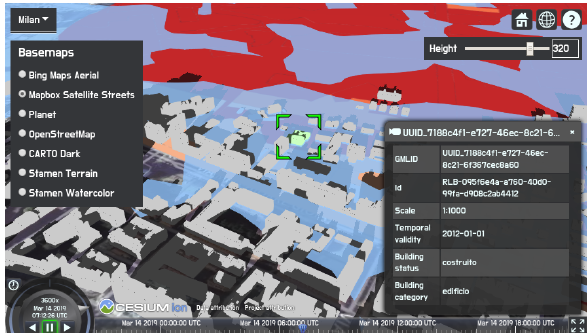
Figure 4. Flood simulation in Milan with flood risk map and 3D buildings visualization and